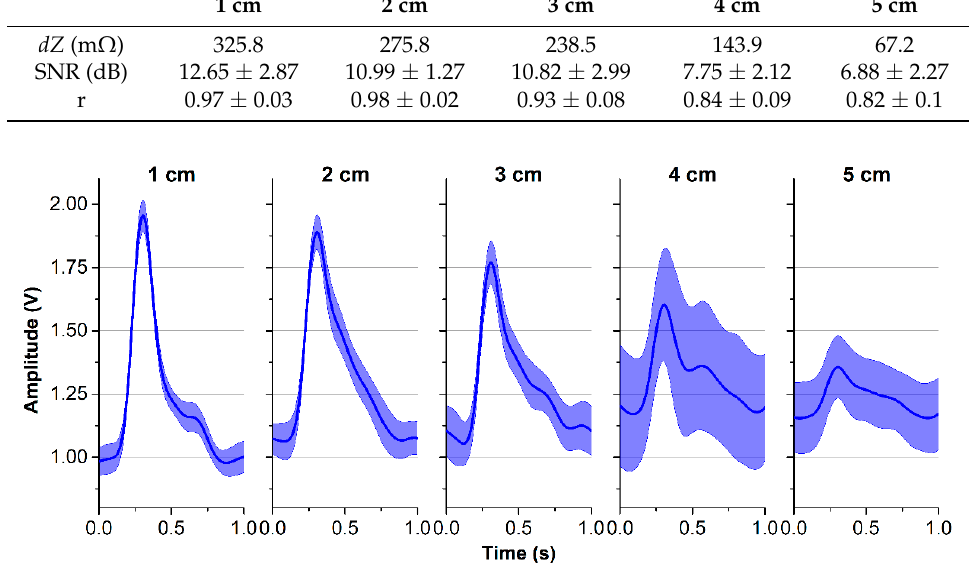
Table 1. Impedance variation, signal-to-noise ratio (SNR) of BI measurement, and correlation coefficients of pulse rate against the commercial device under different location of forearm.